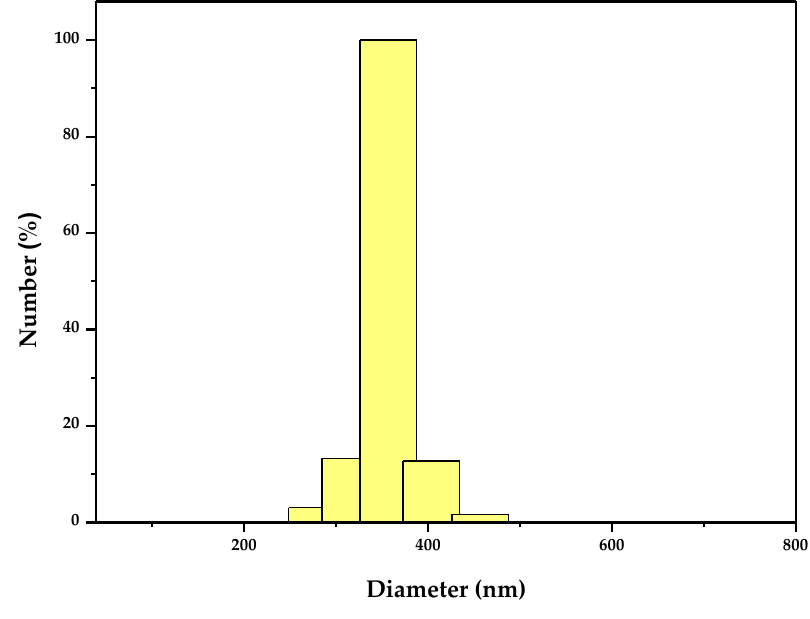
Figure 4. The diagram of particle size of ZnBiErO 4 .